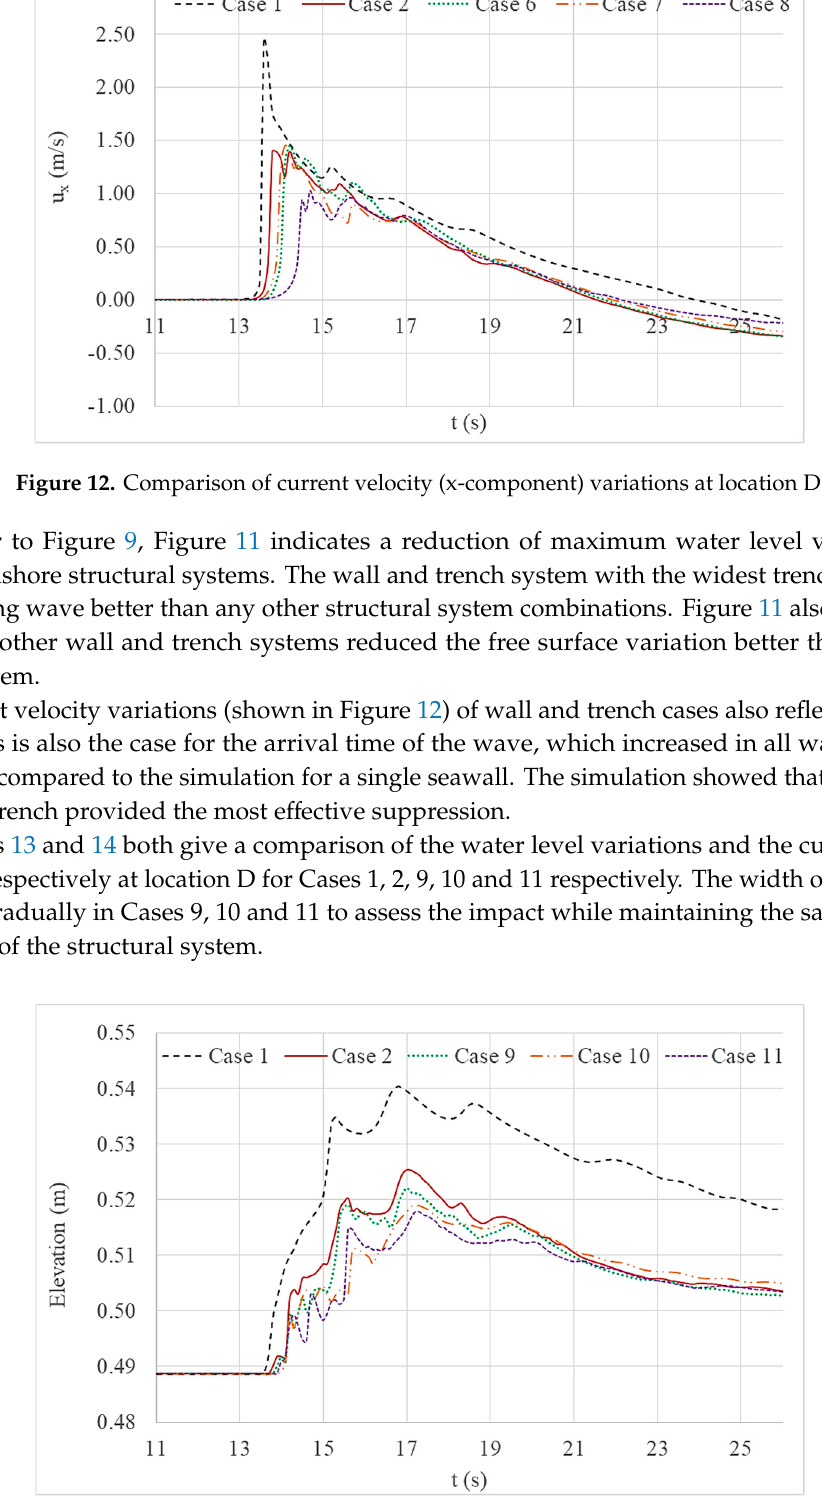
Figure 11. Comparison of water level variations at location D.